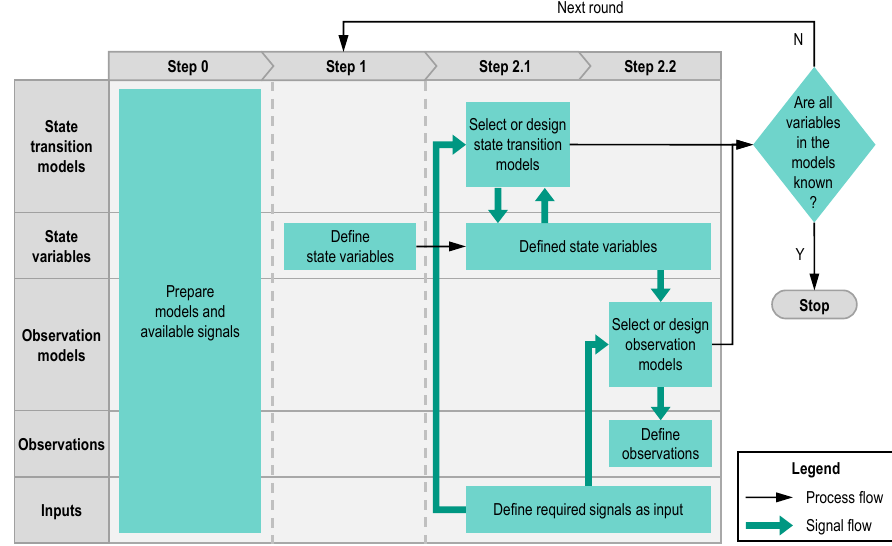
Figure 6. Flow chart of modular approach to designing state estimator.